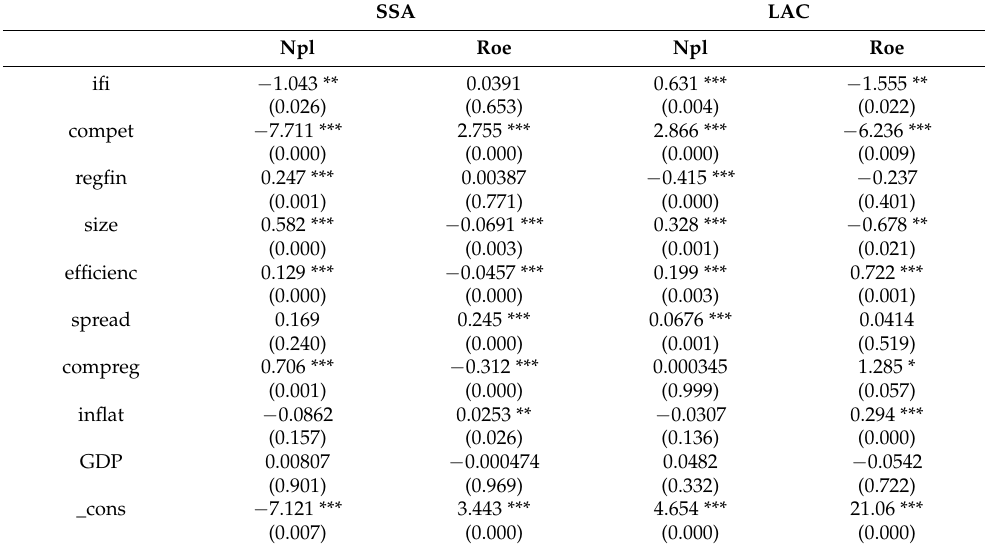
Table 12. Effect of financial inclusion on credit risk and